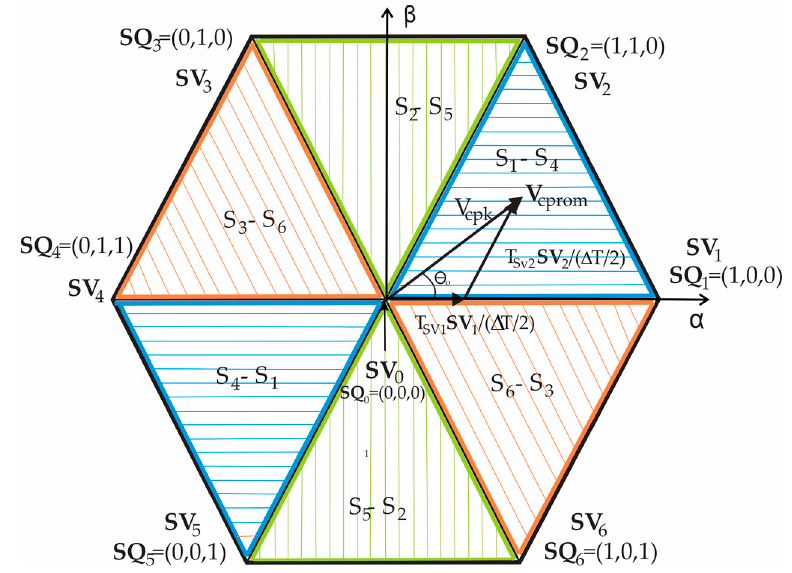
Figure 3. Space Vector Bi-dimensional plane. Table 2. Switching states vectors.